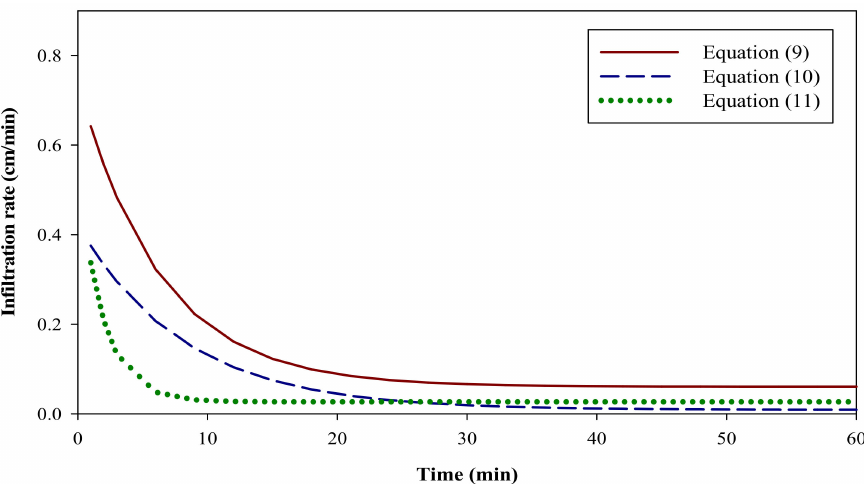
Figure 9. Infiltration rate vs. time by the Horton infiltration model, plotted for di ff erent initial water contents at permanent wilting point, between permanent wilting point and field capacity, and field capacity in Equations (9)–(11),